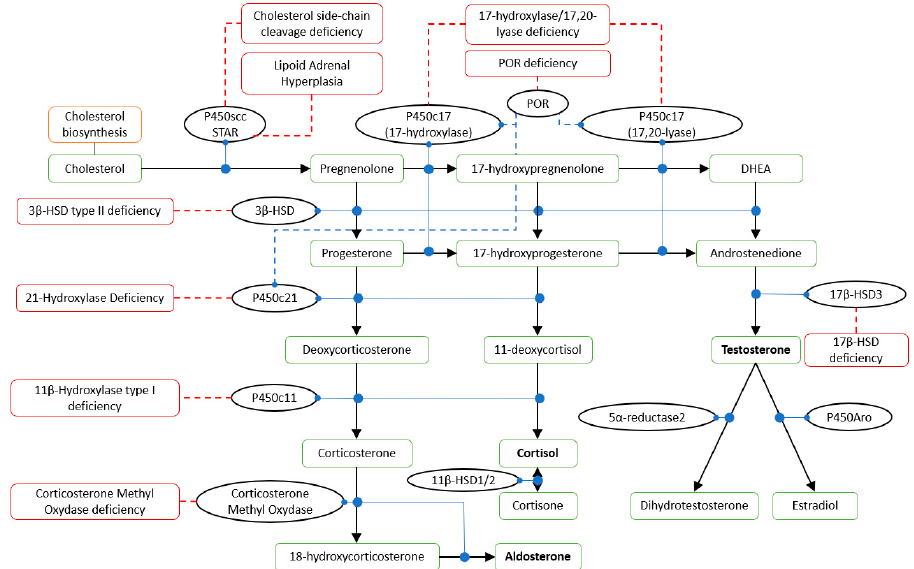
Figure 1. Steroid hormones synthesis pathway. P450scc: cholesterol side-chain cleavage enzyme; STAR: steroidogenic acute regulatory protein; POR: cytochrome P450 reductase; P450c17: steroid 17 alpha-hydroxylase/17,20 lyase; HSD: hydroxysteroid dehydrogenase; P450c21: 21-hydroxylase; P450c11: 11 β -hydroxylase; P450Aro: aromatase. Solid black arrows: conversion; solid blue circles: catalysis; dashed blue lines: stimulation; solid dashed red lines: associated disorders.